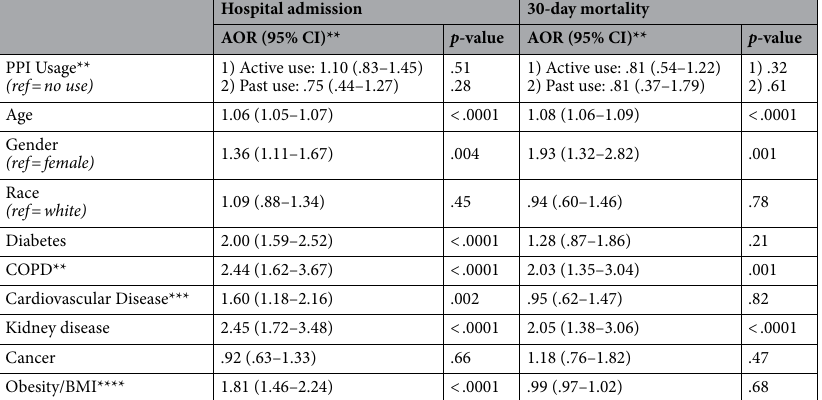
Multivariable regression results are displayed in Table 3. In the regression model, PPI use was not associated with hospital admissions or 30-day mortality. The model found the following variables significant: age, male gender, diabetes, COPD, composite cardiovascular disease, kidney disease and obesity. As further presented in Table 3, the following covariates were significantly associated with increased mortality: age, male gender, COPD and kidney disease. Secondary outcomes for admitted patients based on their PPI use was evaluated and are listed in Table 4. Compared to past and nonusers, active PPI users had slightly higher median hospital length of stayl ( p = 0.02). Additionally, past PPI users had a higher percentage of ICU admissions ( p = 0.03), while both active and past PPI users had higher percentages of diabetes, COPD, composite cardiovascular disease, kidney disease, cancer, and obesity ( p < 0.006). For active and past PPI users (n = 546), pantoprazole was most frequently taken (316, 57.9%), followed by omeprazole (196, 35.9%); esomeprozole (19, 3.5%); lansoprazole (14, 2.6%); dexlansoprazole (5, 0.9%); and rabeprazole (2, 0.4%). Table 5 further presents secondary outcomes for active PPI users only based